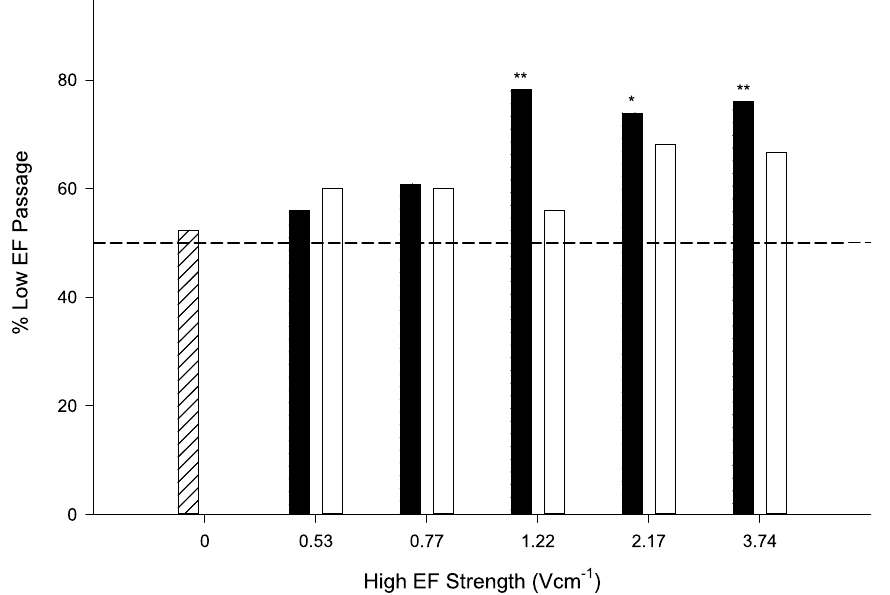
Fig 4. Percentage of upstream migrating juvenile eel that passed the Low Electric Field (LEF) route under the five High EF strengths (0.53, 0.77, 1.22, 2.17 and 3.74 Vcm -1 ) for both 2 Hz (solid bars) and 10 Hz (clear bars) treatments. Control (0 Vcm -1 ) is shown as white hatched bar. The dashed line indicates the expected (50% frequency) random selection if electric field strength has no influence on route choice. Note � denotes p < 0.05 and �� p < 0.01.